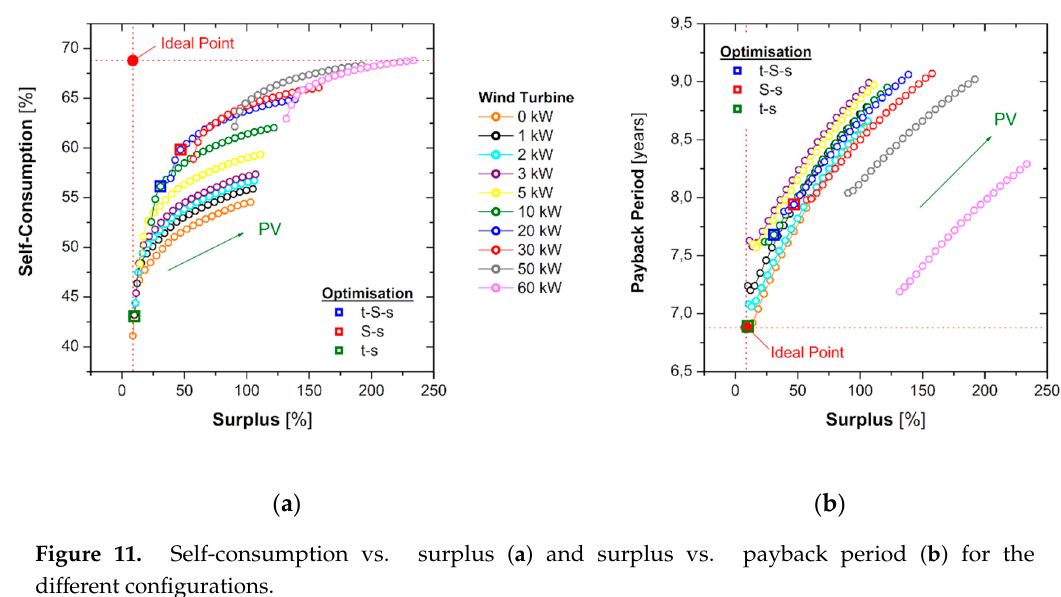
Figure 10. Self-consumption, surplus and payback period for the different configurations.